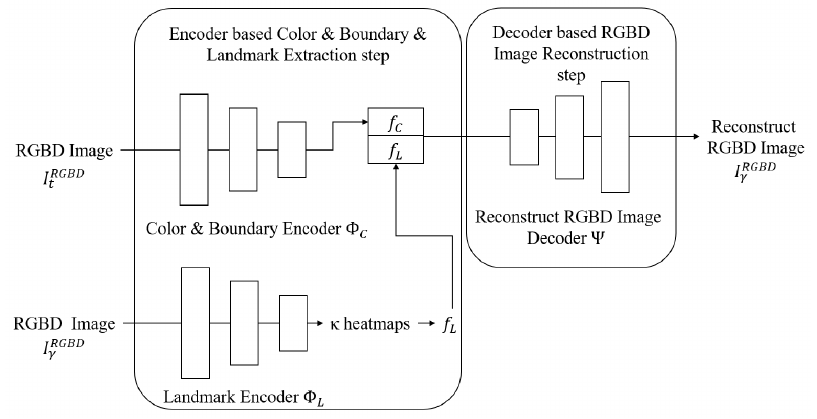
Figure 5. Encoder–decoder model using RGBD image.